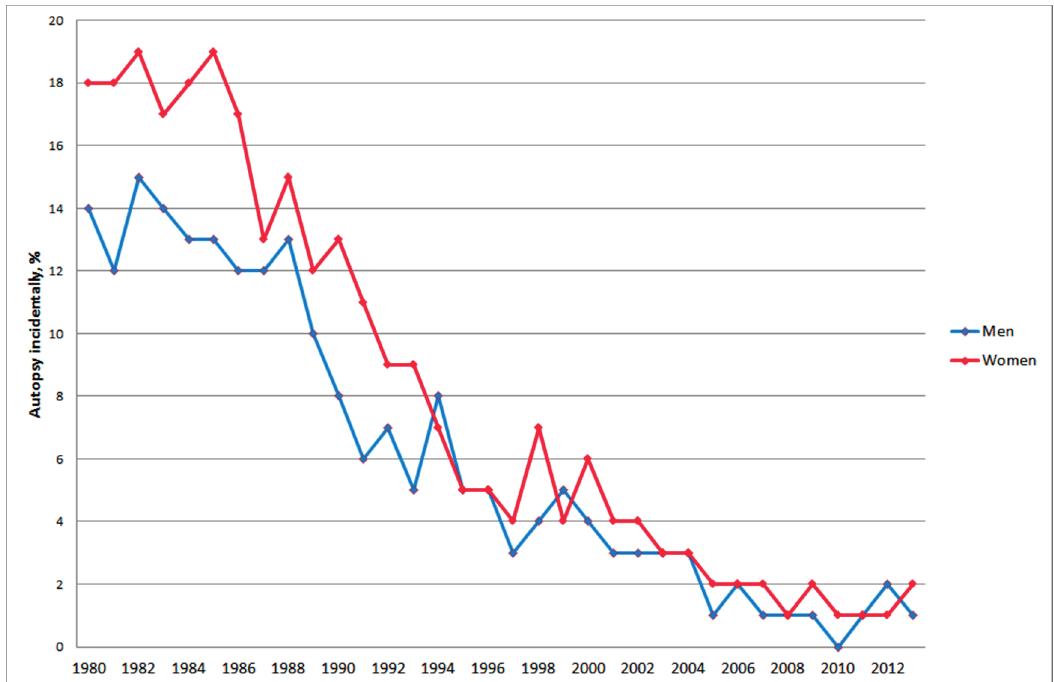
Figure 3. Frequency of nervous system tumours (ICD-7 code 193) based on autopsy for all ages during 1980–2013 according to the Swedish Cancer Register.